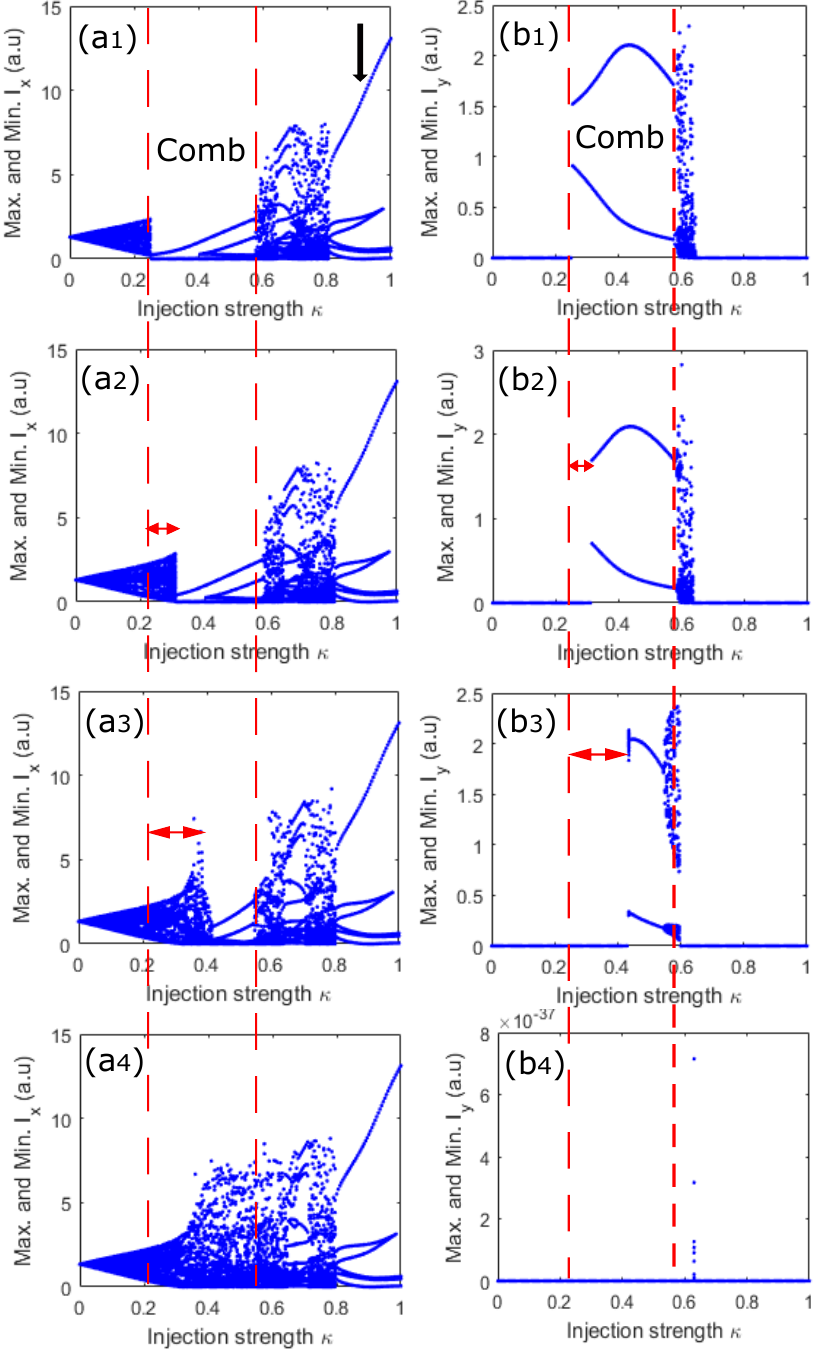
Figure 9. Bifurcation diagrams for fixed injected comb spacing Ω = 2 GHz and detuning ∆ ν x = − 9 GHz. The left and right panels correspond to X-polarization mode (X-PM) and Y- polarization mode (Y-PM). ( a 1 , b 1 ), ( a 2 , b 2 ), ( a 3 , b 3 ) and ( a 4 , b 4 ) are obtained for γ a = − 0.1 ns − 1 , γ a = − 0.2 ns − 1 , γ a = − 0.6 ns − 1 and γ a = − 0.8 ns − 1